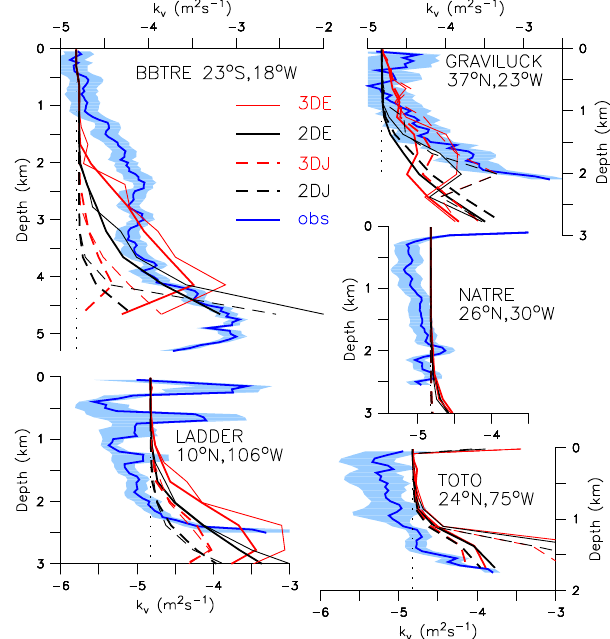
Fig. 12. Comparison of simulated (red, black) k v with observa- tions (blue) from the Brazil Basin (St Laurent et al., 2001; BBTRE, top left), the subtropical Mid-Atlantic Ridge crest (St Laurent and Thurnherr, 2007; GRAVILUCK, top right), the tropical eastern Pa- cific (LADDER, Thurnherr and St Laurent 2011, bottom left), the North Atlantic subtropical gyre (NATRE, St Laurent and Schmitt, 1999, center right), and the Bahamas (TOTO, bottom right). All observations are based on microstructure measurements and were downloaded on 15 March 2013 from http://www.whoi.edu/science/